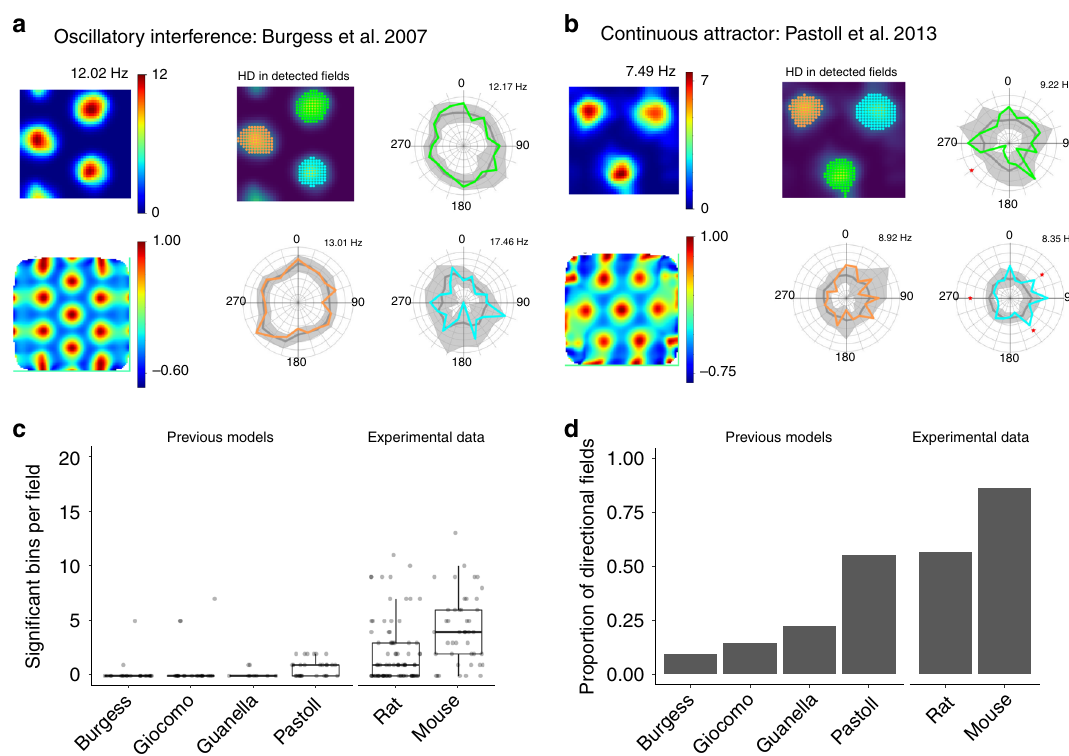
Fig. 6 Existing models do not account for directional modulation of grid fi ring. a , b Firing rate map (upper left), autocorrelogram (lower left), detected fi elds (upper centre) and distributive plots for the colour-coded fi elds for two types of grid models ran on our trajectory data. c Number of signi fi cant bins per fi eld compared across previous grid cell models and experimental data. Each of the previous models (Burgess, Giocomo, Guanella and Pastoll 9,12,13,23 ) differed signi fi cantly from the mouse data ( p = 5.7 × 10 − 8 , p = 9.6 × 10 − 5 , p = 3.4 × 10 − 8 , p = 4.2 × 10 − 7 , respectively, one-way ANOVA with Games – Howell test), and each of the models differed signi fi cantly from the rat data, with the exception of Giocomo ( p = 6.7 × 10 − 4 , p = 0.32, p